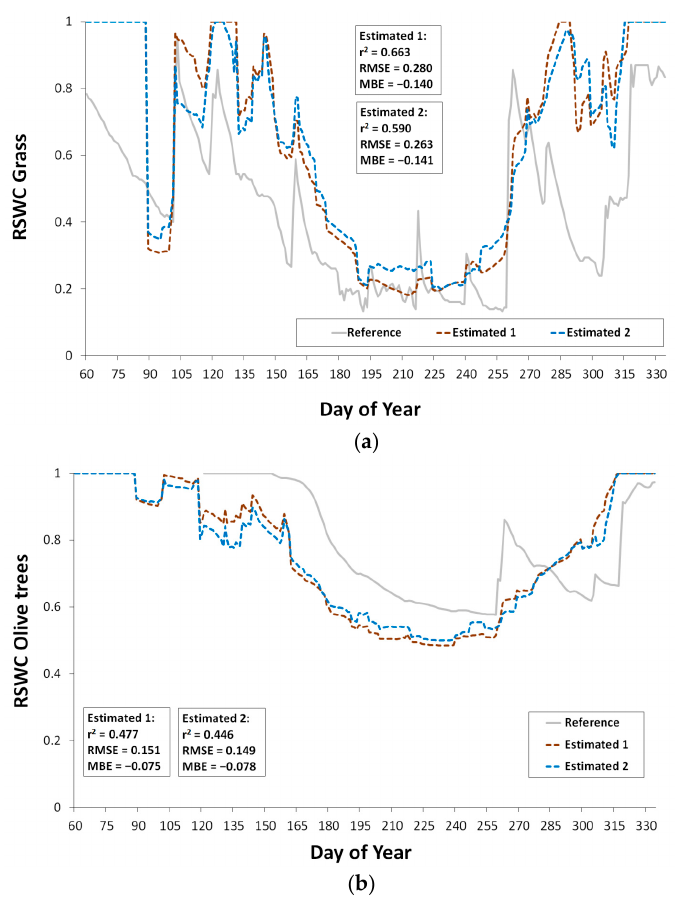
Figure 6. Reference RSWC evolutions compared to the estimates obtained using ground (Estimated 1) and combined (Estimated 2) meteorological data for grass ( a ) and olive trees ( b ) at the Cascine site (all correlations are highly significant, p < 0.01).